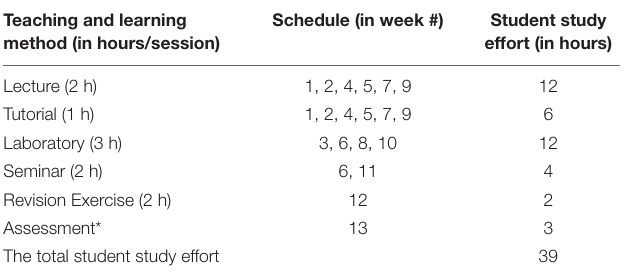
TABLE 7B | Revised teaching plan for the radio frequency identification